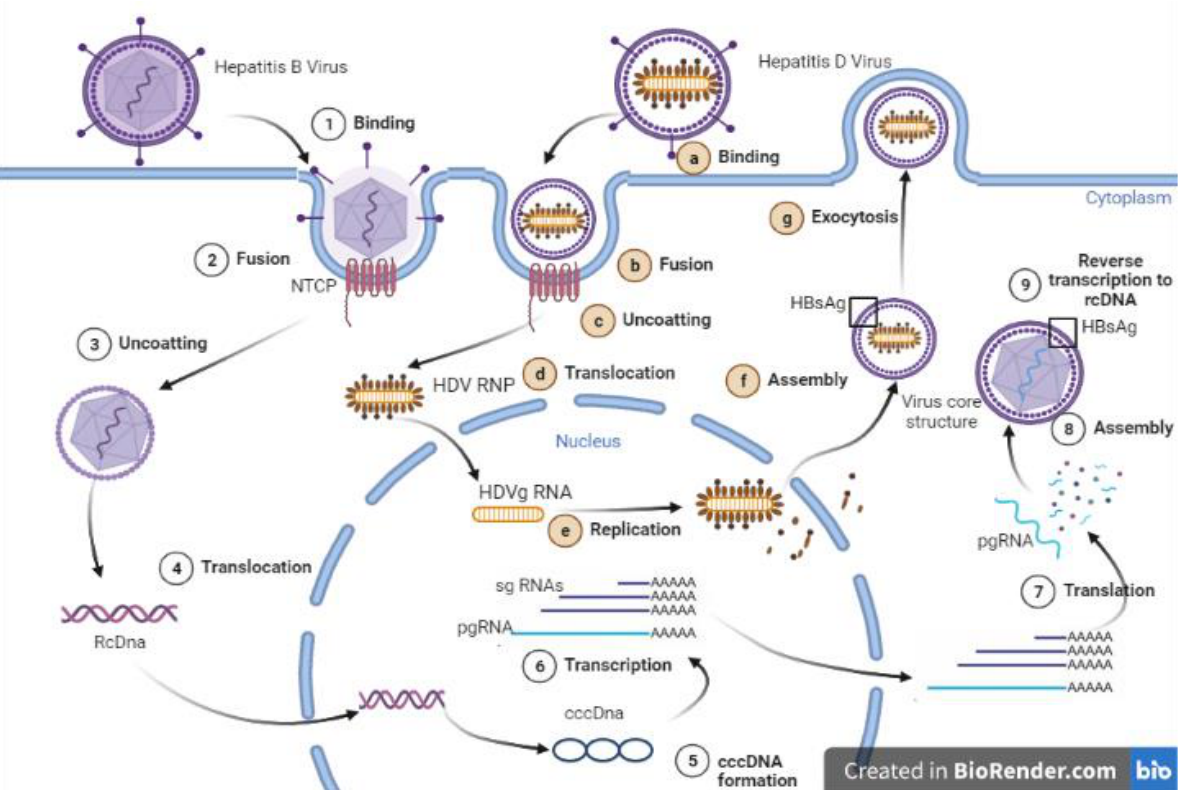
Figure 3 : Upon interaction with the surface of the hepatocytes heparan sulphate proteoglycans (HSPGs), a region of HBsAg (large) binds to the receptor of HBV NTCP. For HDV, the viral RNP move (translocate) to the nucleus for transcription of genomic RNA first into complementary anti- genomic RNA, then into new genomic RNA and mRNA using its host enzymes like polymerase II. The HDV ribonucoprotein (RNP) becomes envelope when it interacts with HBV, which then pro- vide the surface protein (HBsAg) component. The viral and cellular components are assembled in a small vesicles and